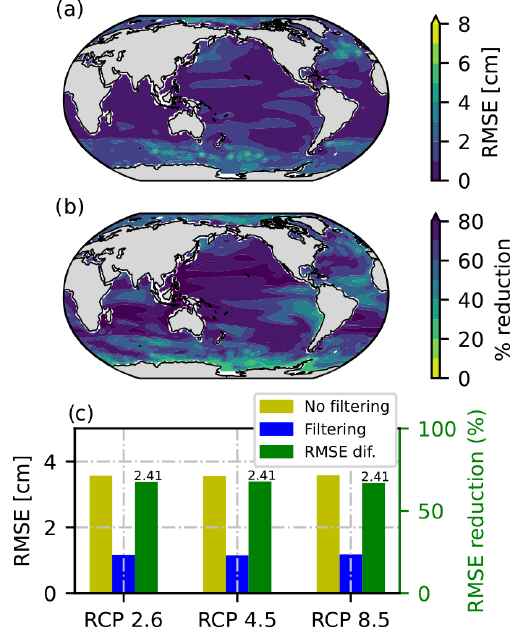
Figure 7. Regional pattern scaling performance based on regres- sion RMSE when one (RCP2.6) ensemble member is filtered via LFCA (a) . Filtering is performed individually for each ensemble member to compute 100 scaling patterns whose results are aver- aged to diminish sampling issues. Differences in regression perfor- mance between Fig. 5a (unfiltered one-member pattern scaling) and panel (a) are shown in (b) in terms of percentage. The area-weighted average RMSE is shown in (c) for RCP2.6, 4.5, and 8.5 and depend- ing on whether the ensemble member is (blue) or is not (yellow) filtered. Green indicates RMSE reduction between approaches in terms of percentage, whereas values on top of the bars are the abso- lute differences in centimeters.